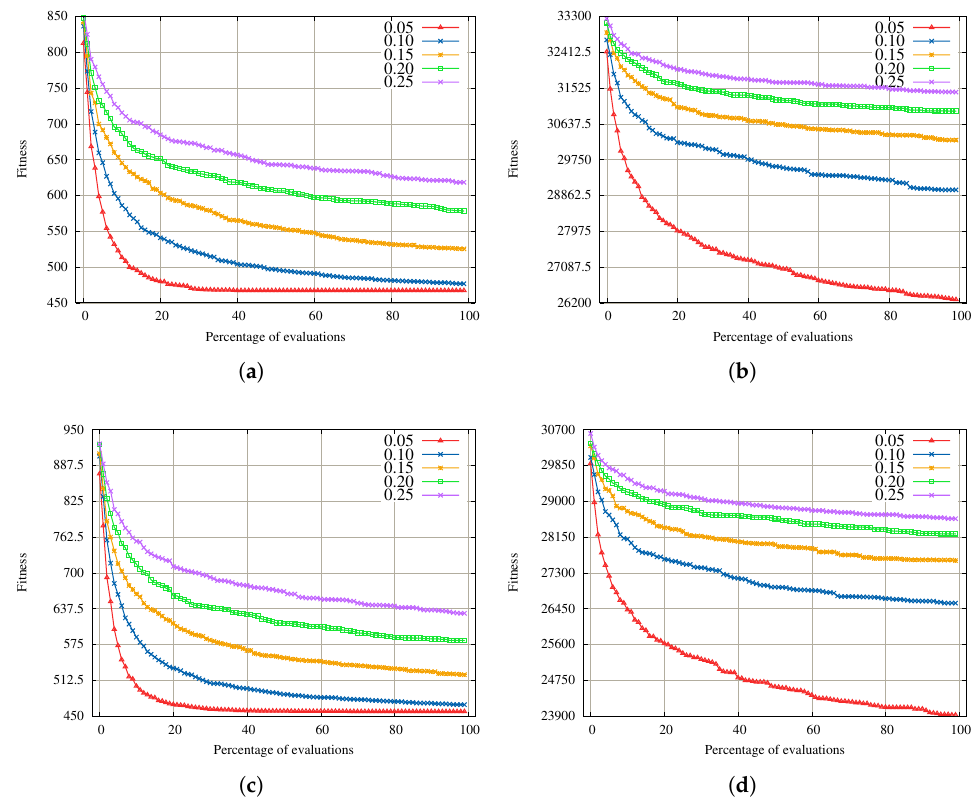
Figure 6. Mutation rate sensitivity GA. ( a ) Instance 1 from the small set (Small 1 ). ( b ) Instance 1 from the large set (Large 1 ). ( c ) Instance 2 from the small set (Small 2 ). ( d ) Instance 5 from the large set (Large 5